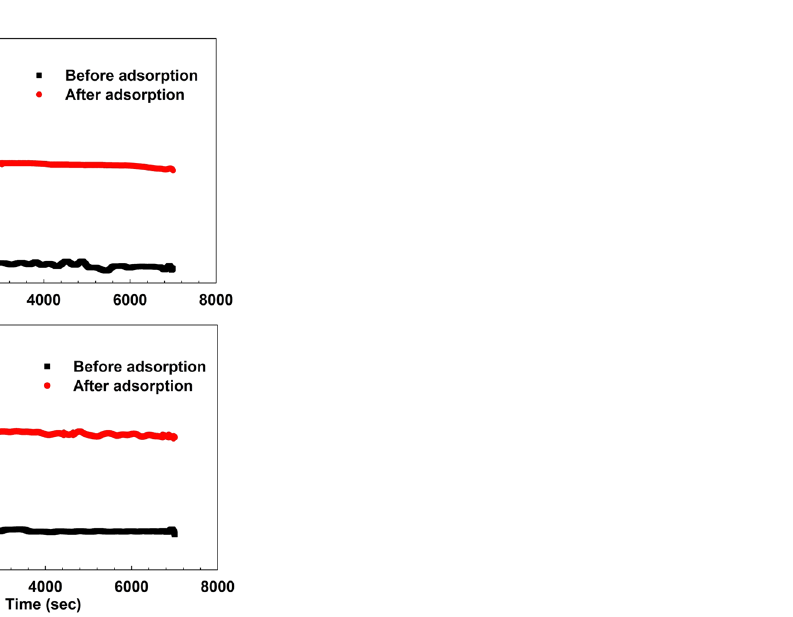
Figure 13. The maximum current densities obtained for the calcined samples versus the zeta potential for the samples (A) before and (B) after MO adsorption.